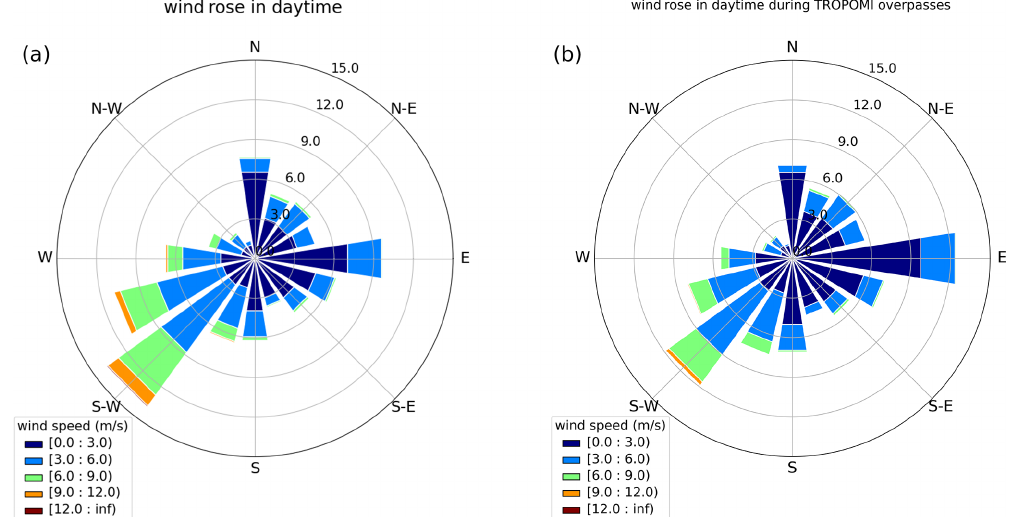
Figure A4. Wind roses for daytime (08:00–19:00UTC) from 10 November 2017 to 11 September 2020 from the wind measurements at the Cuatro Vientos Airport. Panel (a) covers all days and panel (b) covers the days with TROPOMI overpasses.